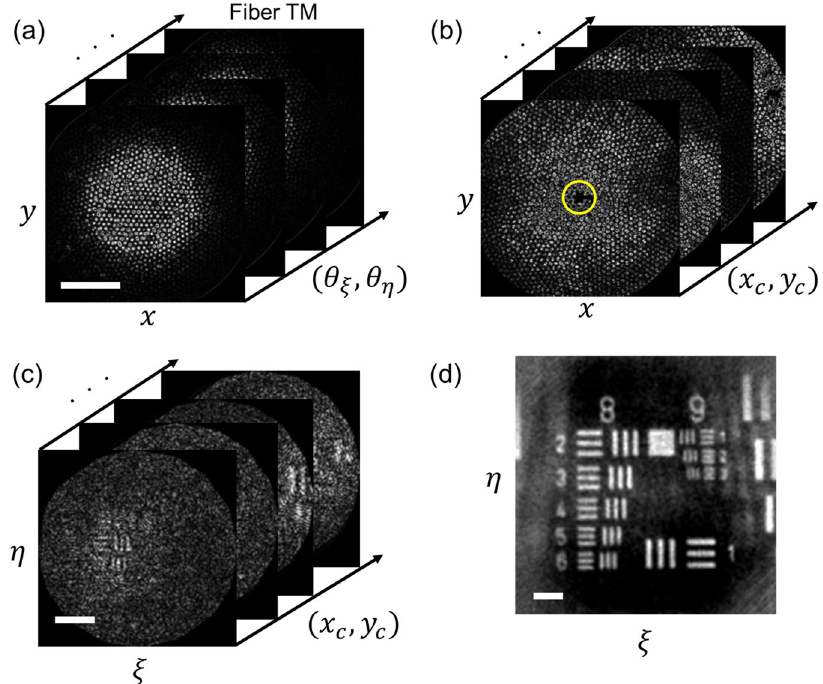
Figure 3. Image acquisition using the single-core illumination and wide-field detection scheme. ( a ) Transmission matrix of the fiber bundle. Complex field maps were recorded at ( x,y ) for the scanning of illumination angle ( θ ξ , θ η ) at the ( ξ , η ) plane. Scale bar: 50 μ m. ( b ) Recording of sample images at ( x,y ) with focused illumination from individual fiber cores ( x c ,y c ). The dark spot indicated by a yellow circle is the core fiber through which the illumination was focused. ( c ) Object images reconstructed by multiplying each of the individual images in ( b ) with the inverse of the transmission matrix in (a). Scale bar: 20 μ m. ( d ) Incoherent summation of all the images in ( c ). Scale bar: 10 μ